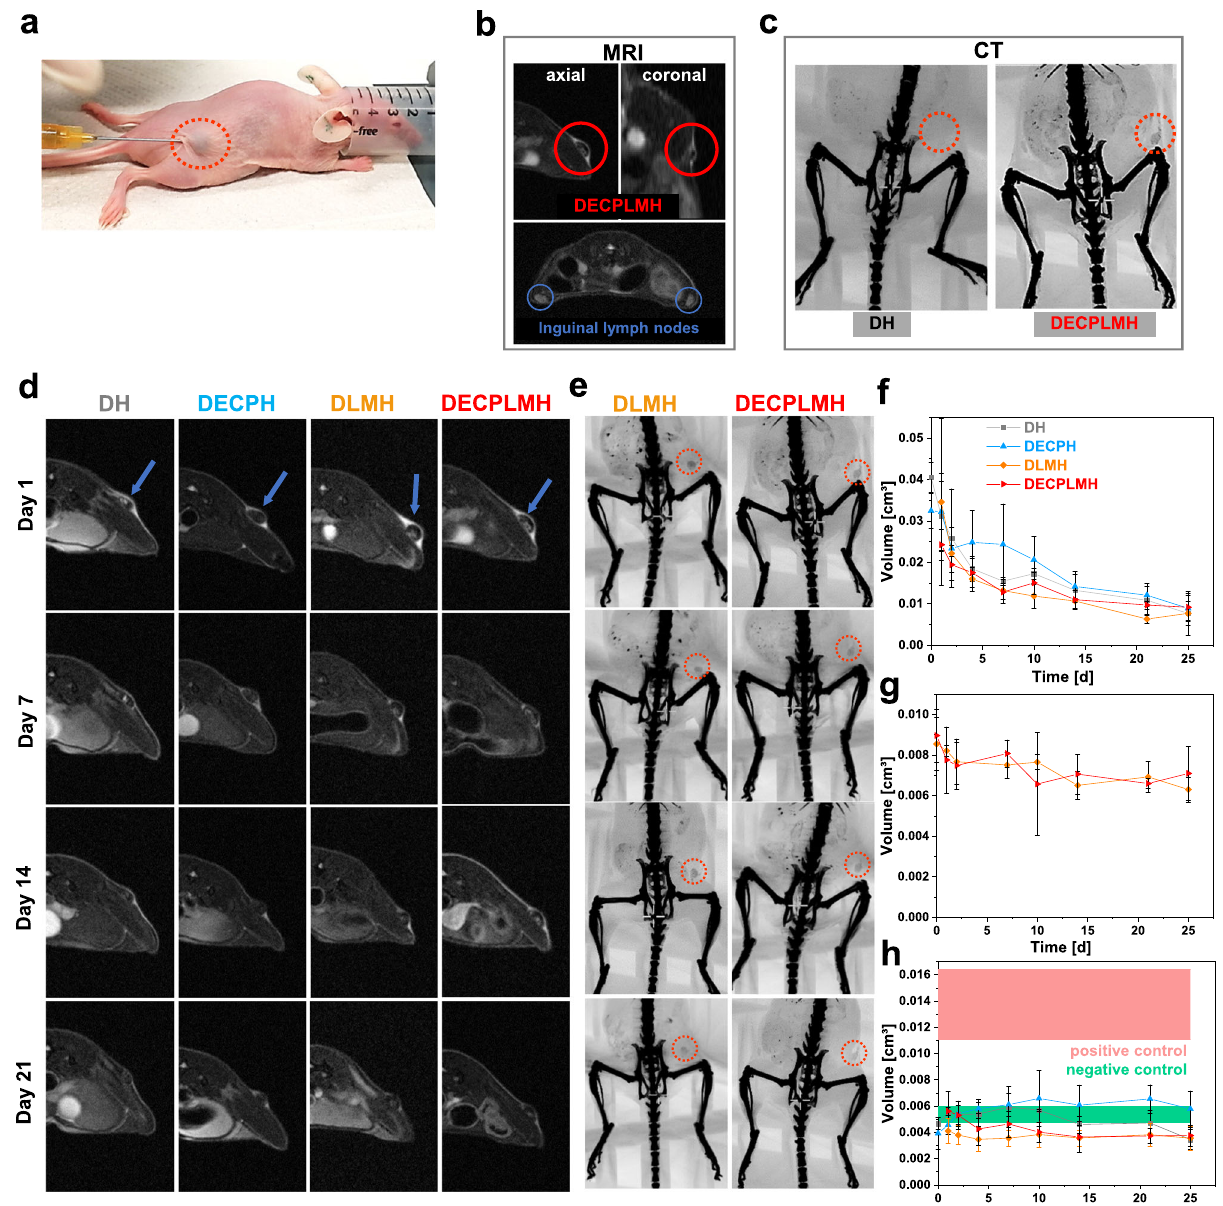
Fig. 8 In vivo hydrogel degradation and biocompatibility. a Exemplary picture to show the subcutaneous injection of the DECPLMH. b Magnetic resonance imaging (MRI) images of hydrogels and inguinal lymph nodes. c Computed tomography (CT) images of hydrogels containing liquid metal nanoparticles. d Representative MRI and e CT images used for volume determination of hydrogels (red circles indicate hydrogel localization). A representative image of three individual animals is shown. f Volume determination of hydrogels by MRI ( n = 3 independent animals, mean ± SD) and g volume of hydrogels containing liquid metal particles measured by CT ( n = 3 independent animals, mean ± SD); h Inguinal lymph node size at hydrogel injection site determined by MRI, compared to negative (untreated) and positive (TPA injection) controls ( n = 3 independent animals, mean ±